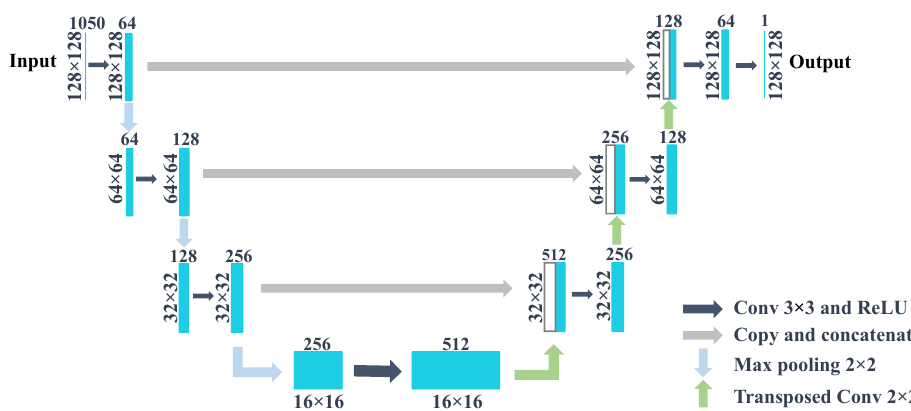
Figure 6. U-Net architecture presented in [19], which is licensed under CC BY